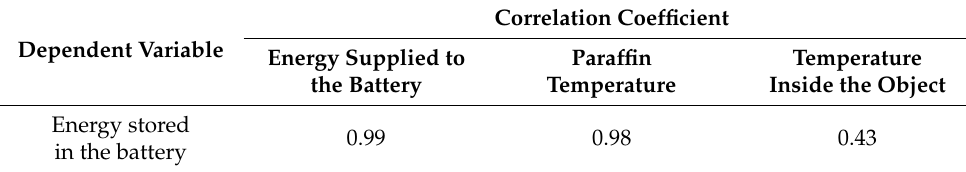
Table 3. The correlation coefficient between the amount of stored electricity in PCM and the indepen- dent variables.